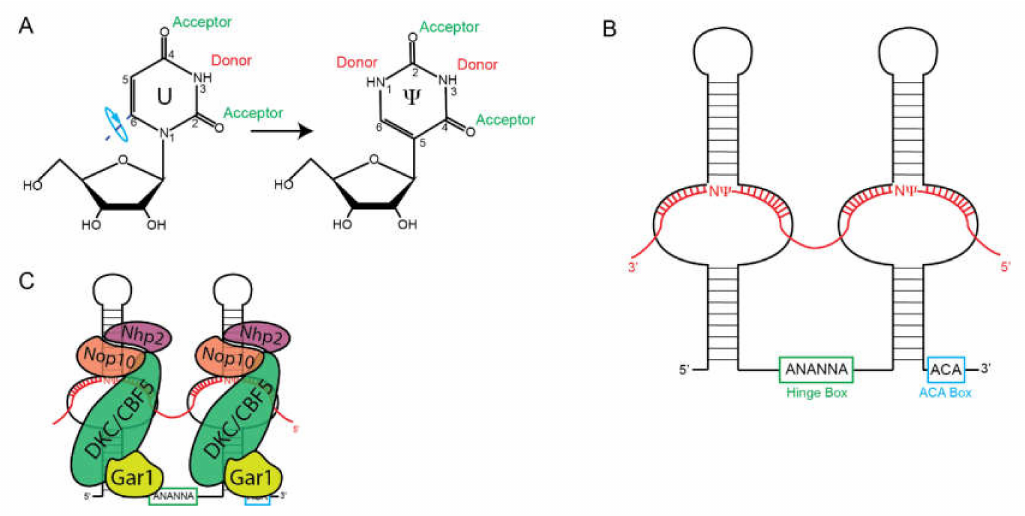
Figure 2. Box H / ACA snoRNPs. ( A ) Isomerization uridine to pseudouridine is catalyzed by Box H / ACA snoRNAs. This generates additional hydrogen bonding capacity that aids in maintaining the ribosome structure. ( B ) Secondary structure of the Box H / ACA snoRNAs, indicating the location of the hinge (H) box (green), ACA box (blue), and hybridized rRNA (red). Pseudouridylation occurs in the “pseudouridylation pocket” at the base of the hairpins. ( C ) Assemblage of protein factors on the